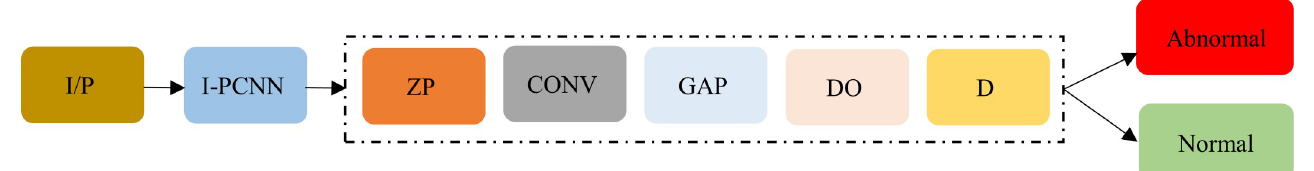
Fig 5. The architecture of the CNNs used in the first stage of repeated CXR-specific pretraining. I/P = Input, I-PCNN = truncated ImageNet-pretrained CNNs, ZP = Zero-padding, CONV = Extra convolution layer, GAP = Global Average Pooling, DO = Dropout, D = Final dense layer with Softmax activation.